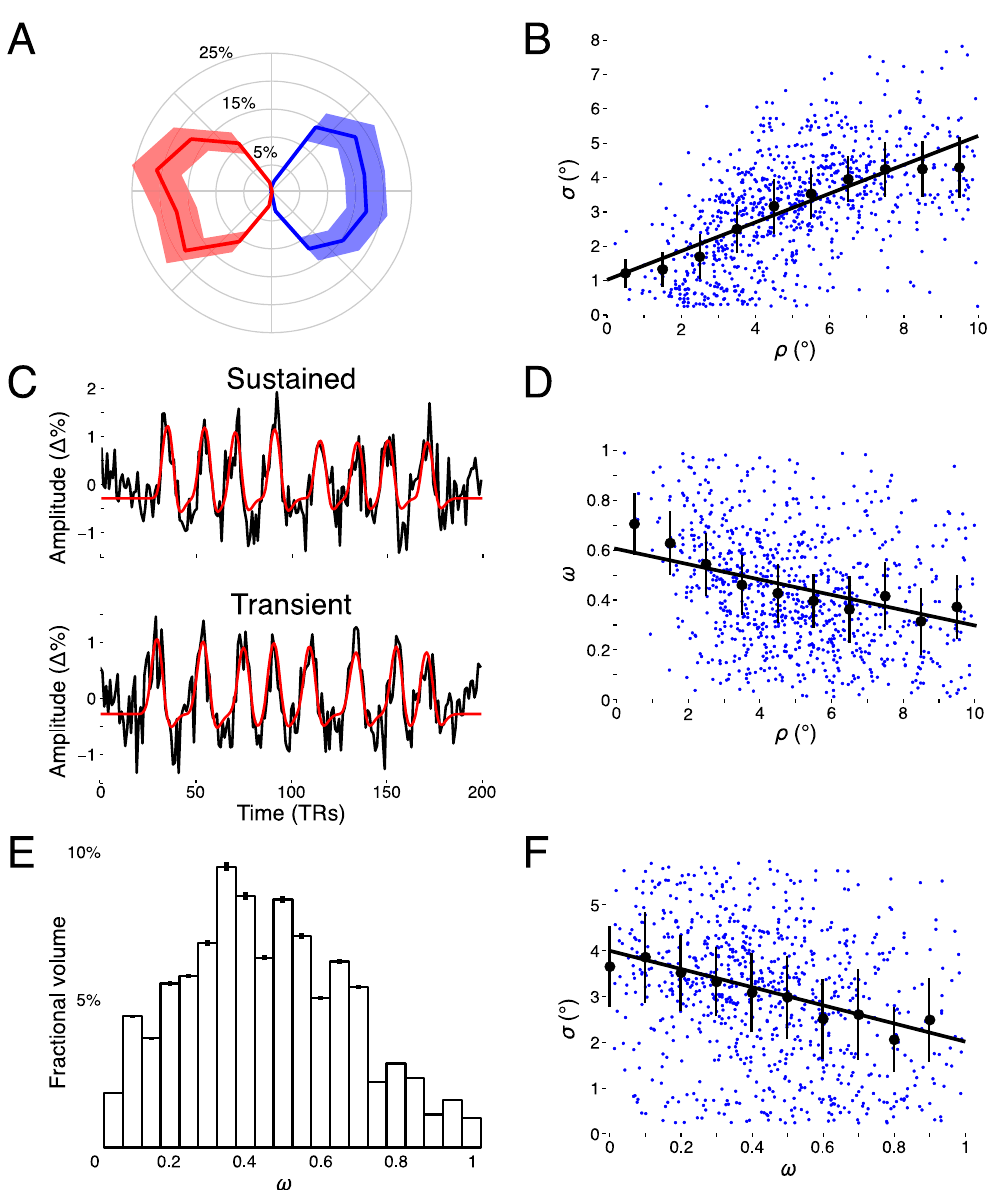
Figure 4. Model estimates. ( A ) Polar angle as a function of fractional volume for left (blue) and right (red) LGN. ( B ) Receptive field size ( σ ) as a function of eccentricity ( ρ ). ( C ) Example voxel data and model fits for a sustained, parvocellular-like (top panel) voxel and a transient, magnocellular-like (bottom panel) voxel time-series [percent signal change ( Δ %)]. ( D ) Transient-sustained weight ( ω ) as a function of eccentricity ( ρ ). ( E ) Distribution of transient-sustained weights as function of fractional volume. ( F ) Receptive field size ( σ ) as a function of transient-sustained weight ( ω ). To test the reliability of the pRF model parameter estimates, we performed a bootstrapping procedure for tracking the variability of the model fits as the number of samples increased. Figure 6 shows the results of this analysis, where the mean deviation across voxels (dot) and variability (bars, 95% confidence intervals) is shown across sample sizes for the pRF estimates and the variance explained. Each color represents a single subject. As the number of samples increases, the error of each voxel decreases, while the explained variance increases. The weight parameter shows a shallower decline in error with increasing sample size compared to the other parameters, suggesting that this model term is most susceptible to